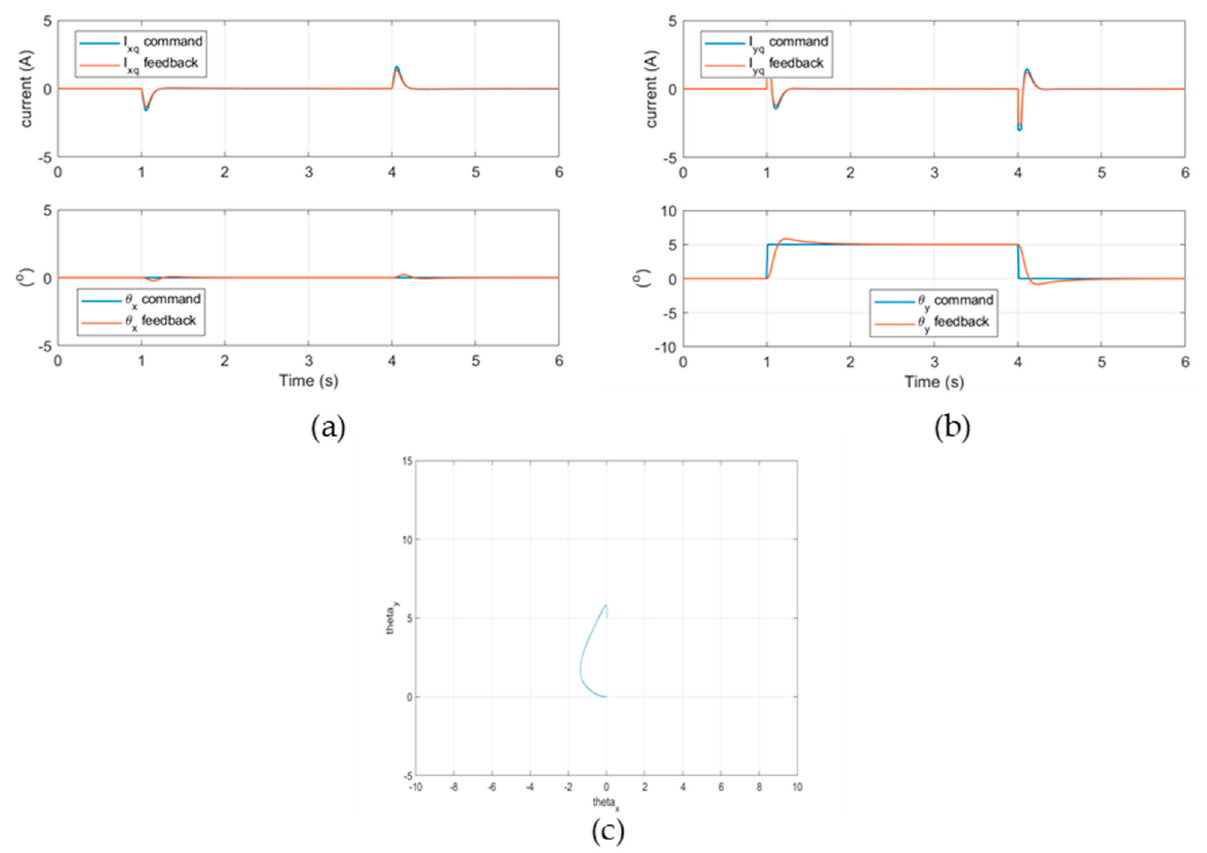
Figure 6. Simulation results for the position control of the HMDOF motor at the rotating motor speed of 1000 RPM: ( a ) The control results of the roll motor; ( b ) The control results of the pitch motor; ( c ) The trajectory of the tilting motors on the θ x − θ y plane.